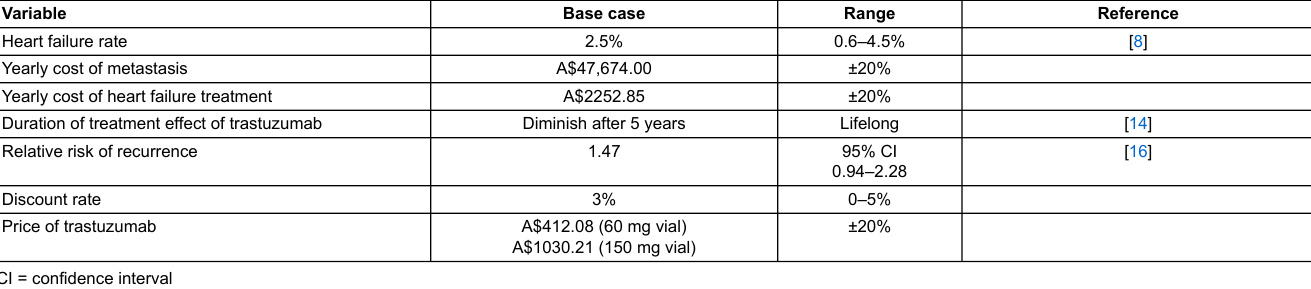
Table 5: Ranges of variation of variables in univariate sensitivity